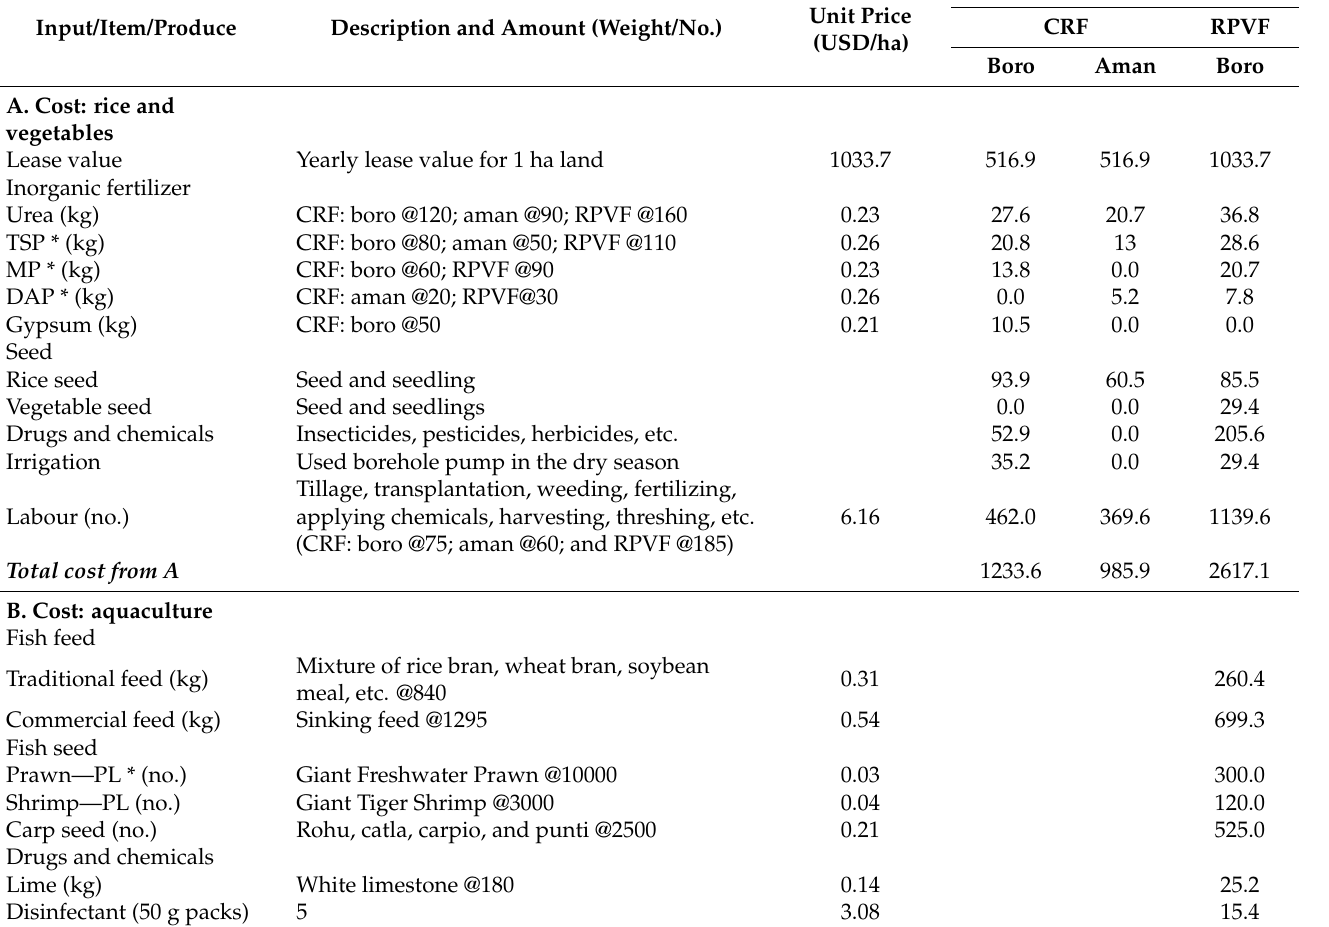
Table 4. Comparative profitability analysis between a hectare of conventional rice farms (CRF)